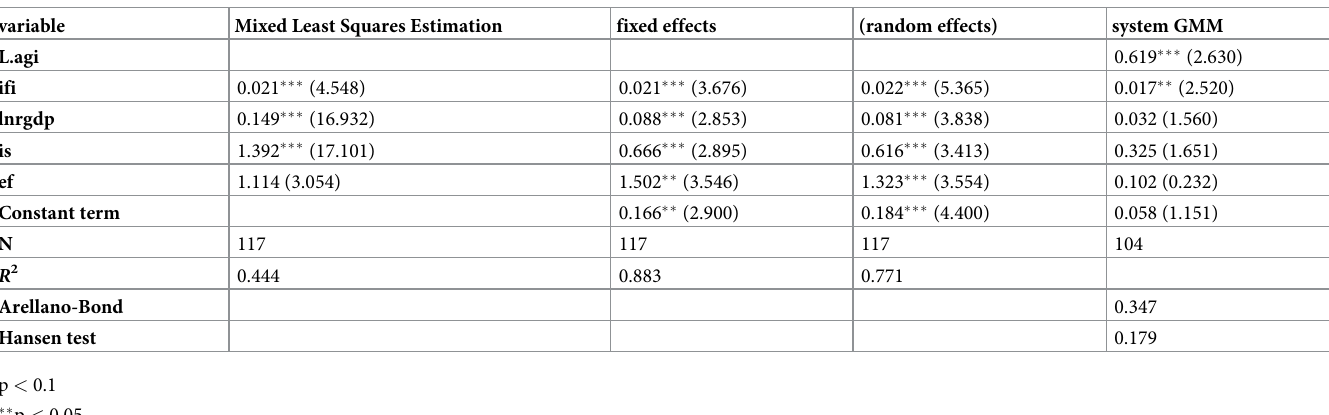
Table 7. Results of stability regression